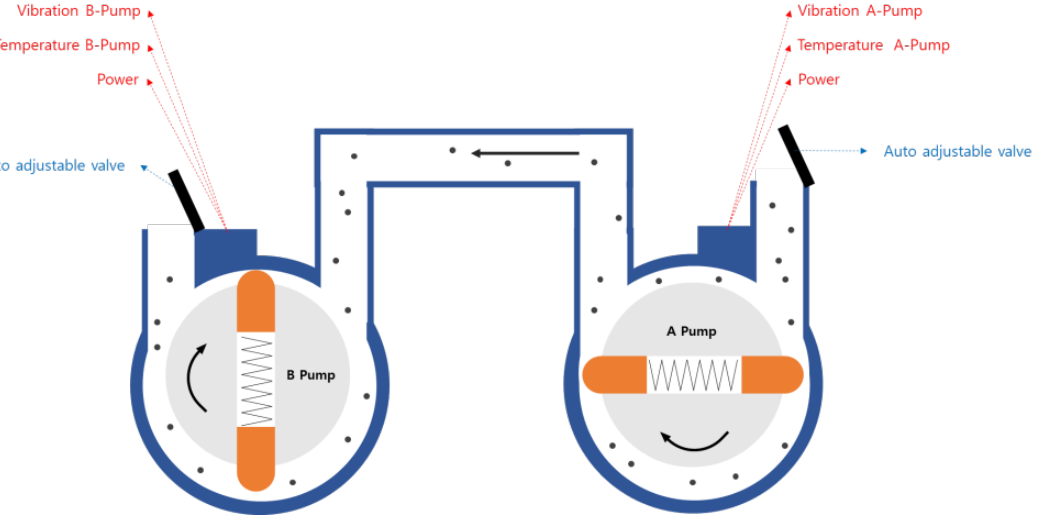
Figure 5. The example of an overall structure of a pump.